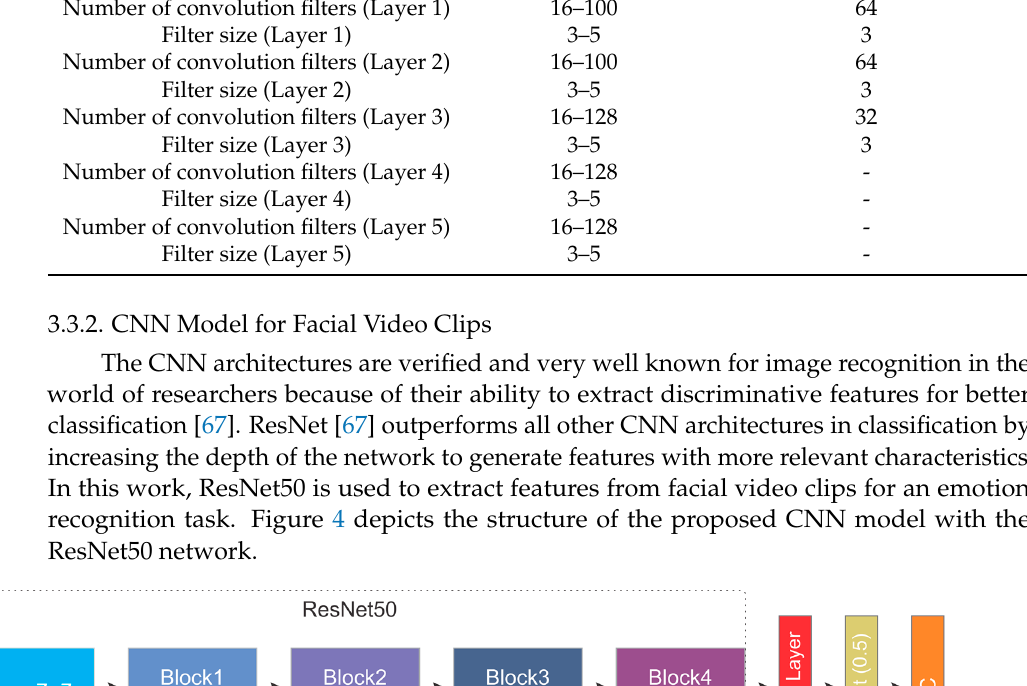
Table 1. Selected hyperparameters and corresponding range to find the optimal values for a light- weight 1D-CNN model.